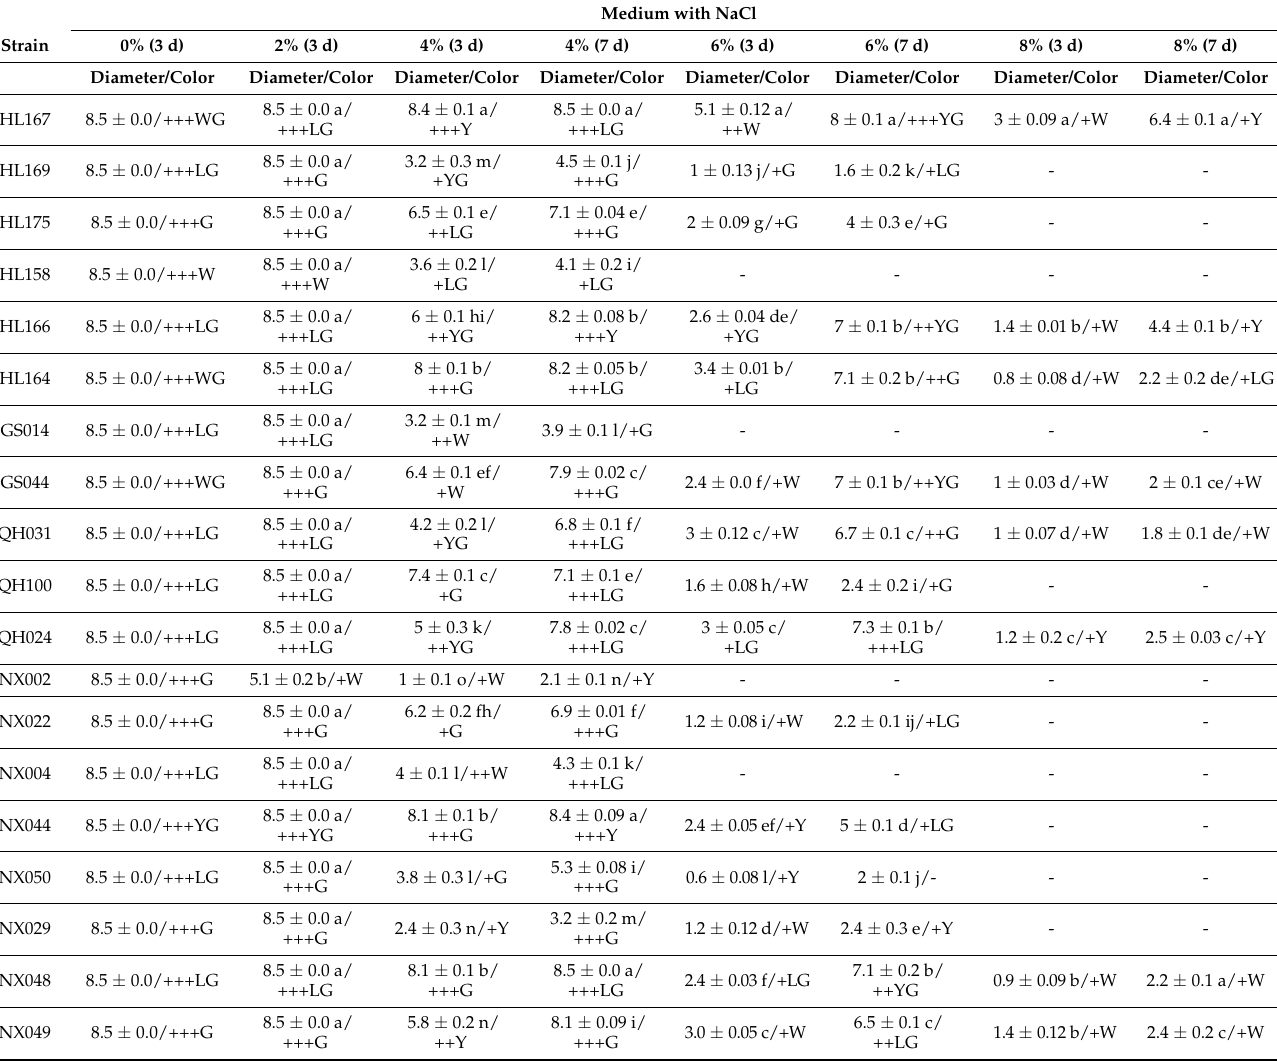
Figure 1. Number of Trichoderma isolates in Gansu, Qinghai, Heilongjiang, and Ningxia provinces of China. ( A ) The percentage of Trichoderma isolated from saline soils of different provinces to the total Trichoderma ; ( B ) The percentage of salt tolerance Trichoderma in each province. Table 2. Growth of Trichoderma media with concentration of NaCl.